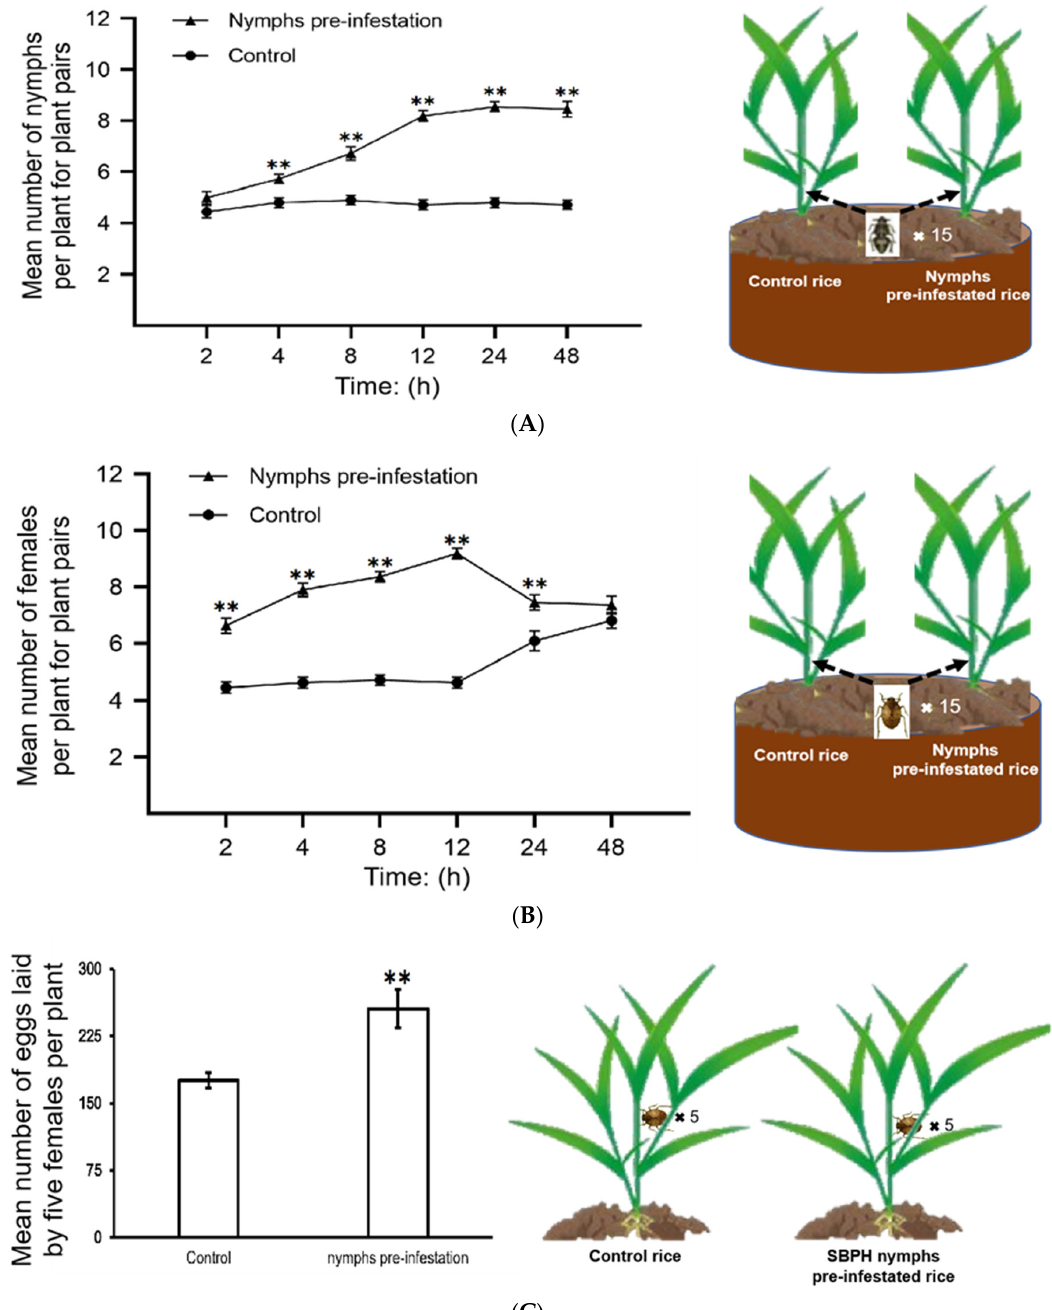
Figure 1. SBPH nymph infestation contributes to SBPH feeding and survival on rice. All of the choice and no choice assays for SBPH were performed after 48 h of continuous nymph pre-infestation; untreated SBPH was used as the control. A and B, SBPH host preference in choice tests. The mean number + SE ( n = 15) of fourth-instar SBPH nymphs ( A ) and female adults ( B ) per plant for plant pairs (SBPH nymphs pre-infested rice vs. control). n , number of biological replicates. Fifteen fourth-instar nymphs or female adults were released per replicate, and the experiment was repeated 12 times. Statistical significance was calculated using GraphPad Prism 8 (Version 8.0.2, GraphPad Software, La Jolla, CA, USA). ** p < 0.01, Student’s t -tests. ( C ) Mean number of eggs laid by five female adults that fed on the control or SBPH nymph pre-infested rice plants for two days; the experiment was repeated 15 times. ** p < 0.01, Student’s t -tests. The model figures in the right half of the graph depict the SBPH choice and no choice